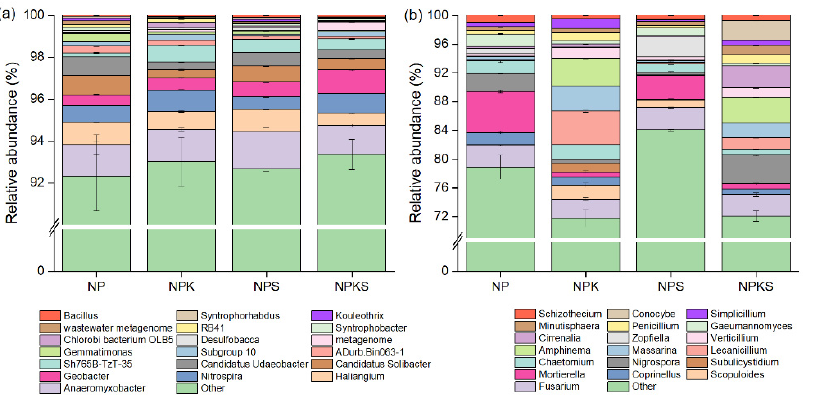
Figure 3. The relative abundance of dominant taxonomic groups for ( a ) bacteria and ( b ) fungi at the genus level. The data represent the mean values of the three replications. Values are means ( n = 3); error bars are standard deviation.